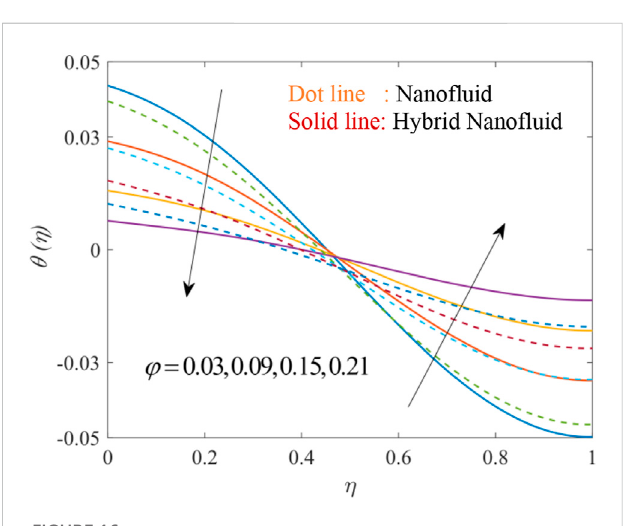
FIGURE 16 Effect of nanoparticles volume fraction φ on θ ( η ) .